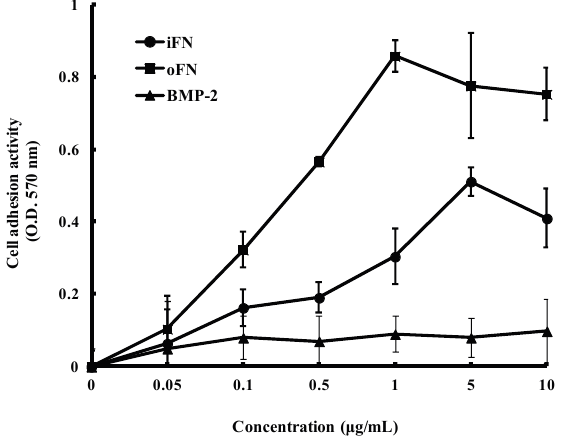
Figure 2. Cell adhesion activity of osteoinductive fibronectin on MC3T3-E1 cells. Cells were seeded at a density of 1 × 10 5 cells/well on plates coated with iFN, oFN, or BMP-2 and incubated for 30 min at 37 °C. Adhesion of MC3T3-E1 cells was measured as described in Experimental Section. The cell adhesion activity is expressed as absorbance and represented as mean ± standard deviation ( n =